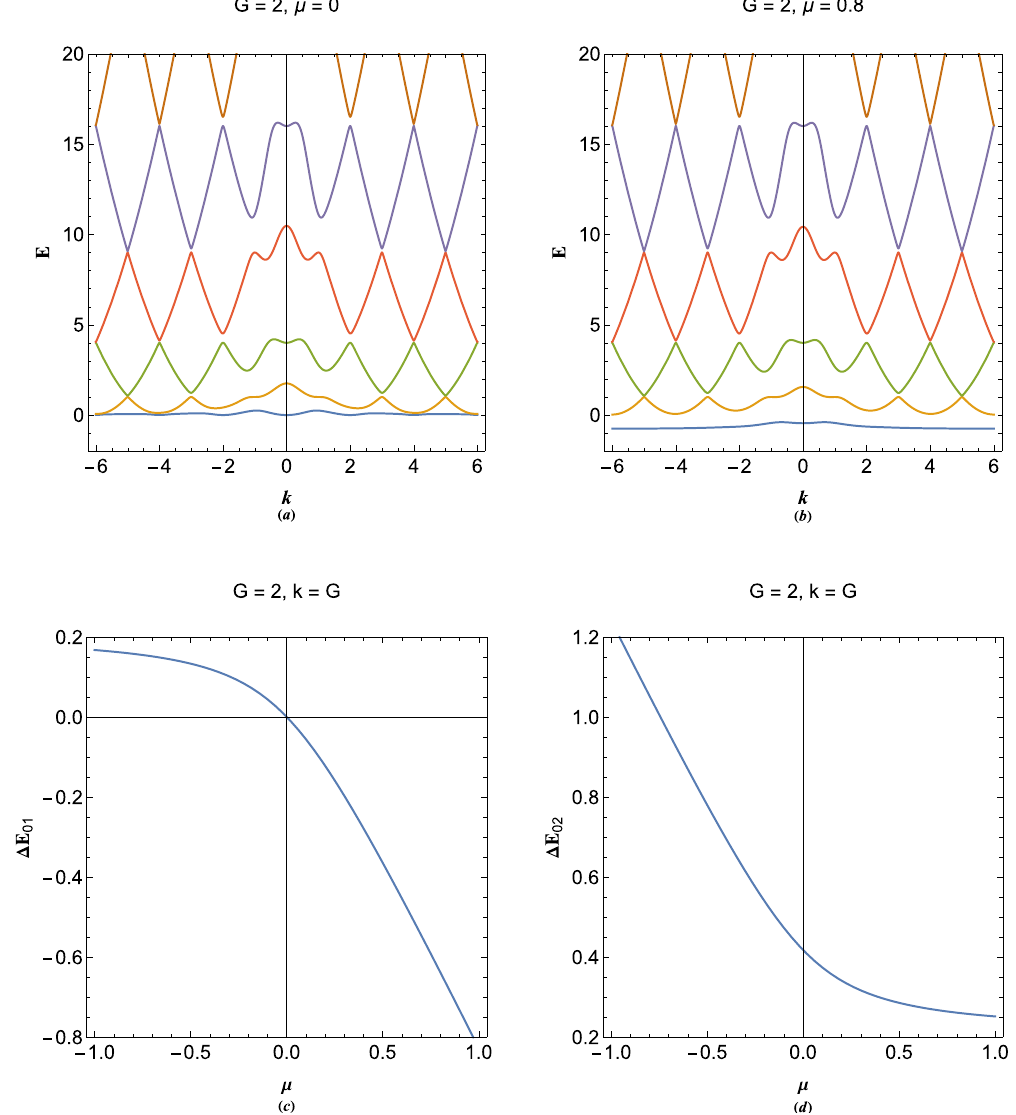
2 in the presence of dynamic ions for ( a ) classical Figure 11. Band structure of 1D plasmonic crystal with G = 0 and ( b ) degenerate electron gas with µ 0.8 . The variation in the gap between ( c ) first electron gas with µ = = band and ( d ) second band from top of Fermi level with the change in normalized chemical plasmon band and the top of Fermi level (cid:31) E 01 at first Brillouin boundary is shown in Fig. 11c in terms of the G touches the Fermi level at exact value of normalized chemical potential. It is seen that the first band at k = µ 0 above/under which value the first band is belove/above the Fermi energy level. Moreover, Fig. 11d depicts = 2 . The second band never touches the Fermi level G for G the gap of second band from Fermi level at k = = for the chemical potential values in semiconductors and metallic density regime. However, the second energy 0 decreases as the chemical potential increases. It should be noted that plasmonic crystals, band gap from E = unlike ordinary solids, can constitute from different charged species other. Also, the lattice sites can be interfaces between different plasmonic (metallic and semiconductor) layers, so called superlattice configuration, which do not contribute electrostatic potential to energy band structure. Therefore, current empty lattice model may well apply to a wide range of plasmonic crystal and superlattice configurations. We have already considered the multistream electrostatic systems which only include electrons and ions. However, the simplified current model may be further generalized to include multispecies complex plasmas with a wide range of mass and charge-state spectrum or even gravitationally coupled uncharged quantum fluids. As discussed earlier, the energy band gap structure formation in quantum multistream system is expected be the origin of collisionless quantum stream instability and Landau damping effects. Therefore it is concluded that, these effects not only are characteristics of electrostatic systems, but also are inevitable in uncharged mass/spin multistream systems coupled through gravitational/magnetic potentials. The fundamental difference between